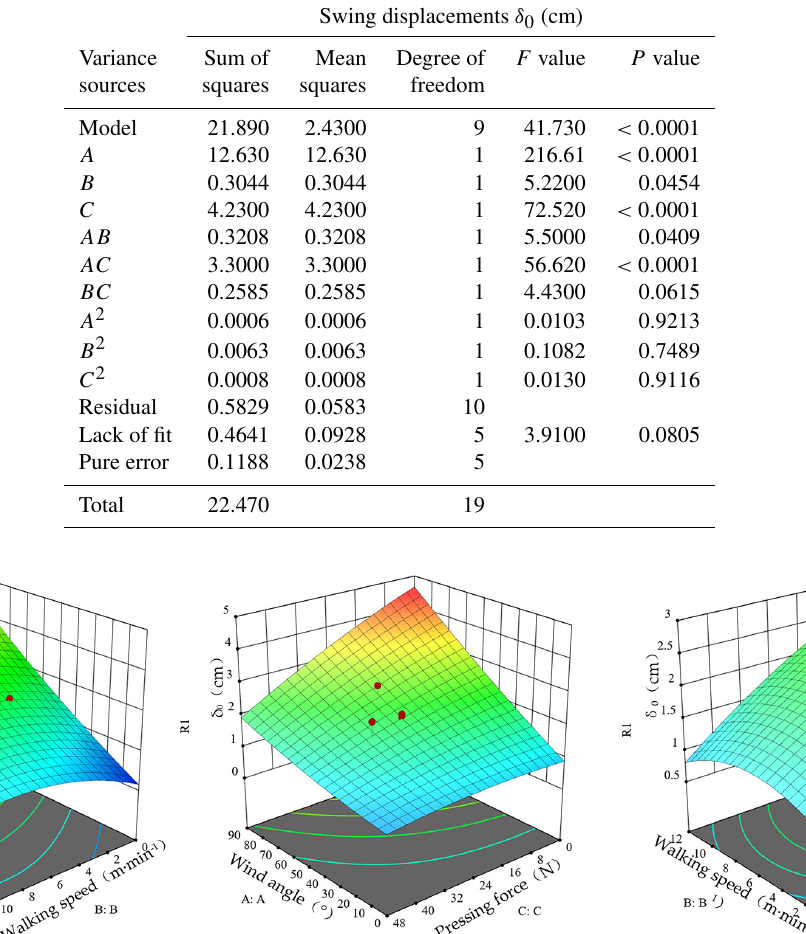
Table 5. Analysis of variance.